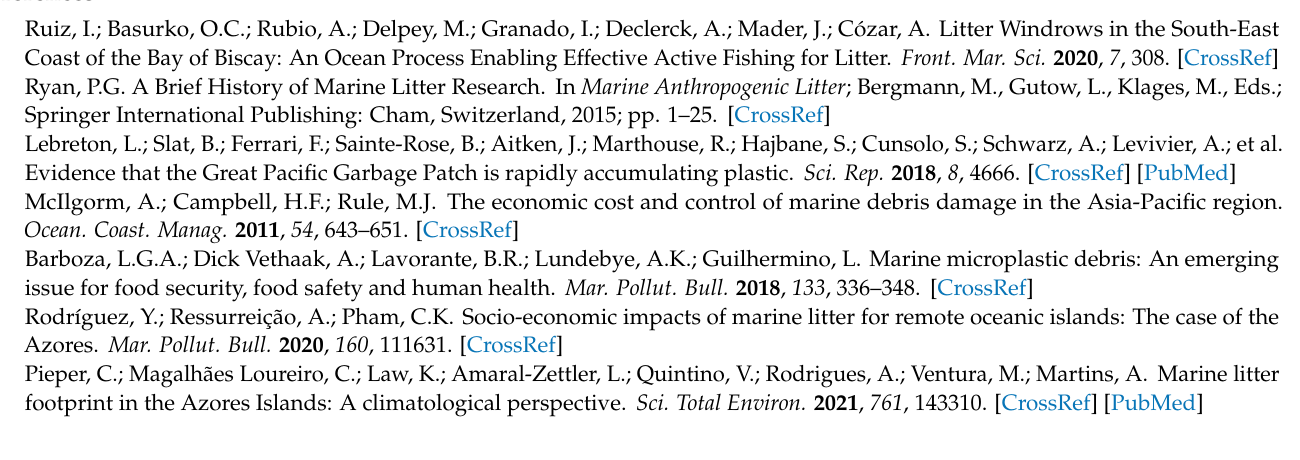
Figure A6. Comparison between the rope target results for F-BUMA flight (600 m altitude), Grifo-X flight (20 m altitude) and laboratory setup, with focus in HySpex Mjolnir S-620 bands (970–2500